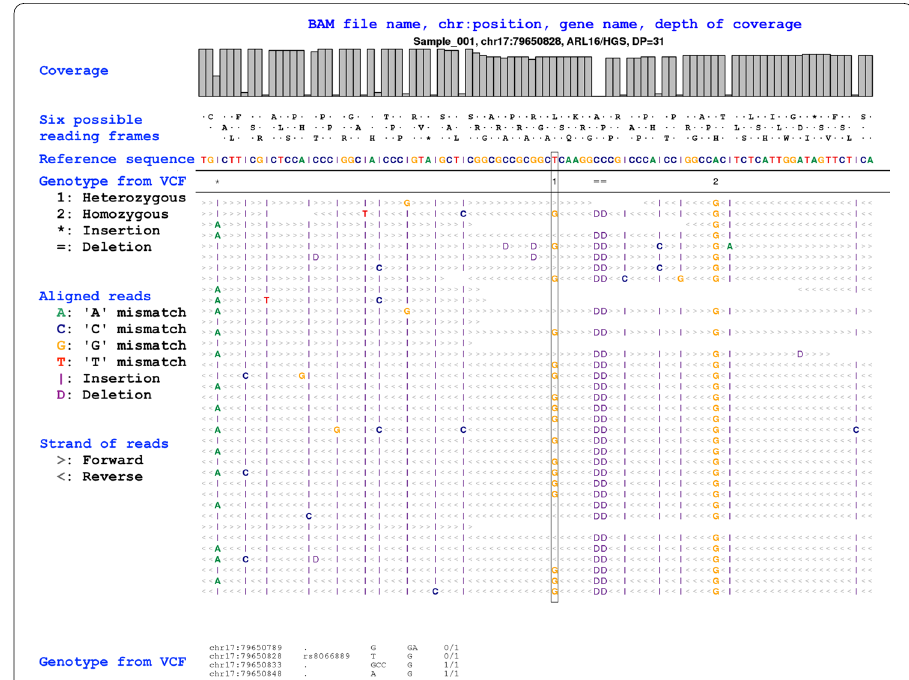
Fig. 2 An example snapshot at chr17:79650828. Sequence reads aligned against a reference genome sequence and base mismatches are displayed in the region of